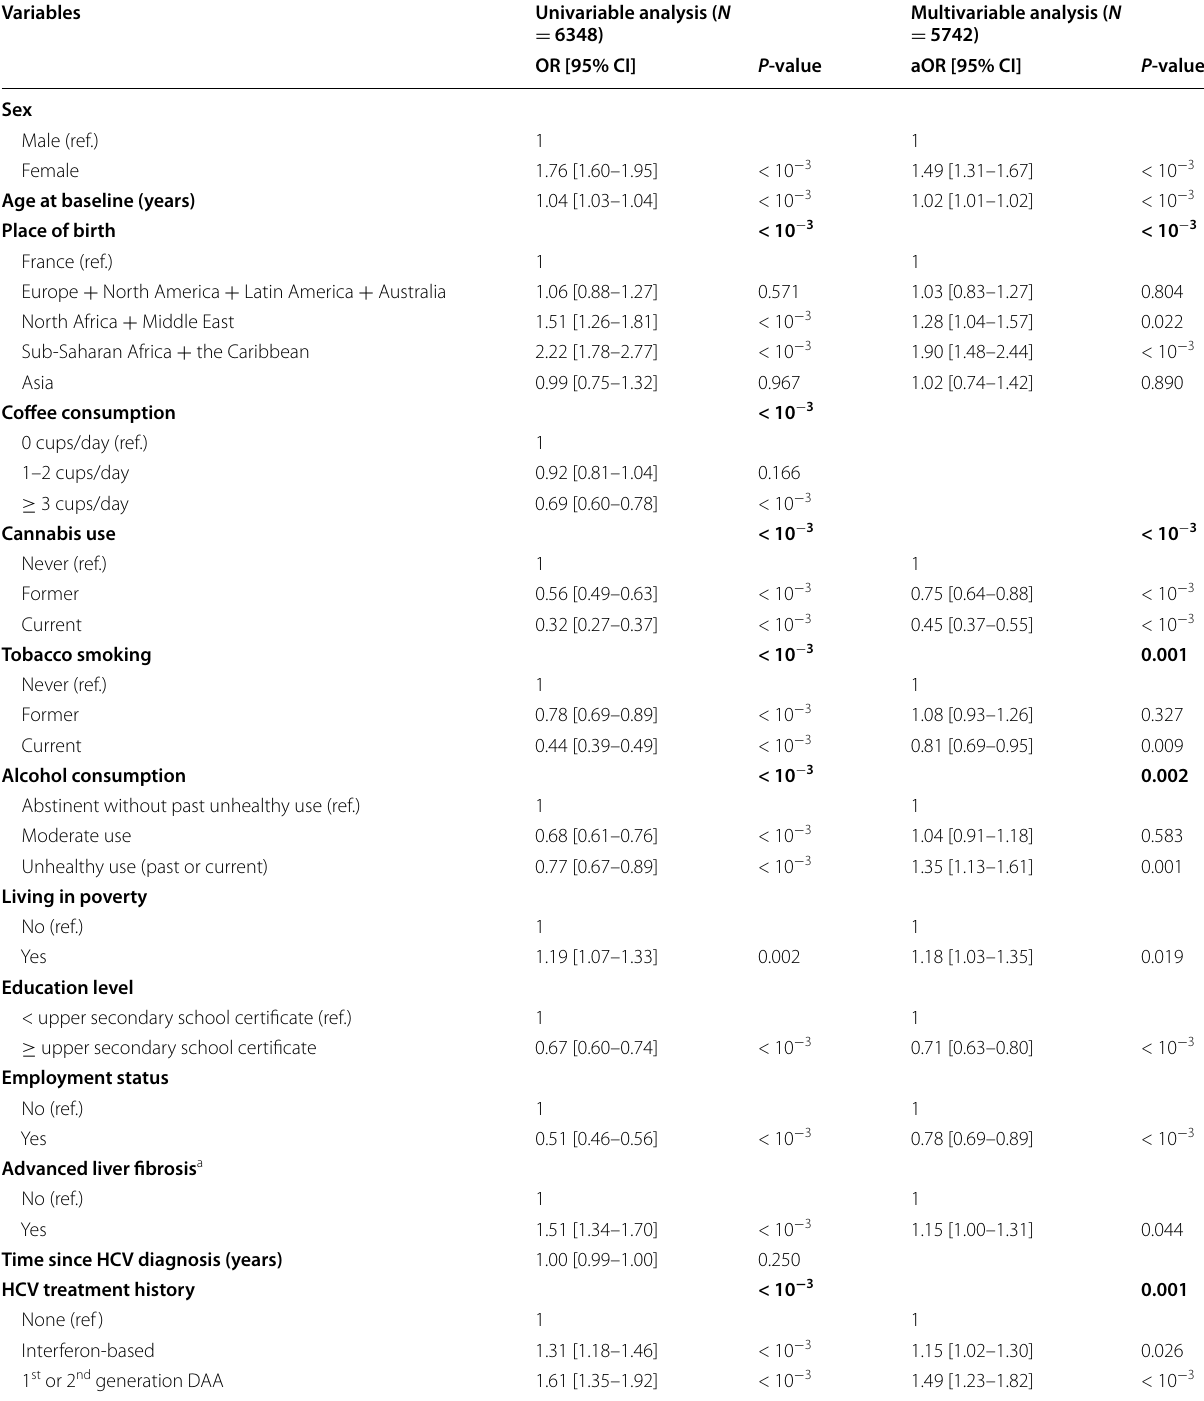
Table 2 Factors associated with central obesity in univariable and multivariable analyses (logistic regression, ANRS CO22 Hepather cohort, N =